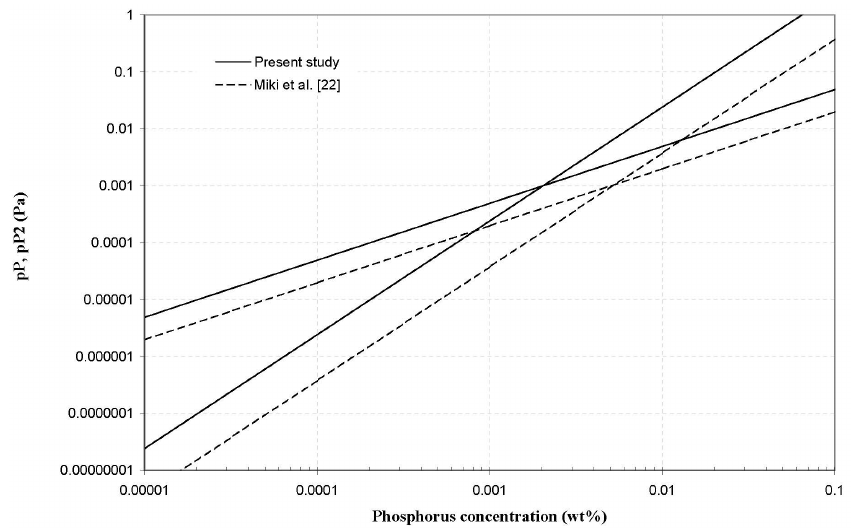
Figure 7. Relationship between the equilibrium partial pressure of P and P 2 gases and the dissolved phosphorus in sili- con at